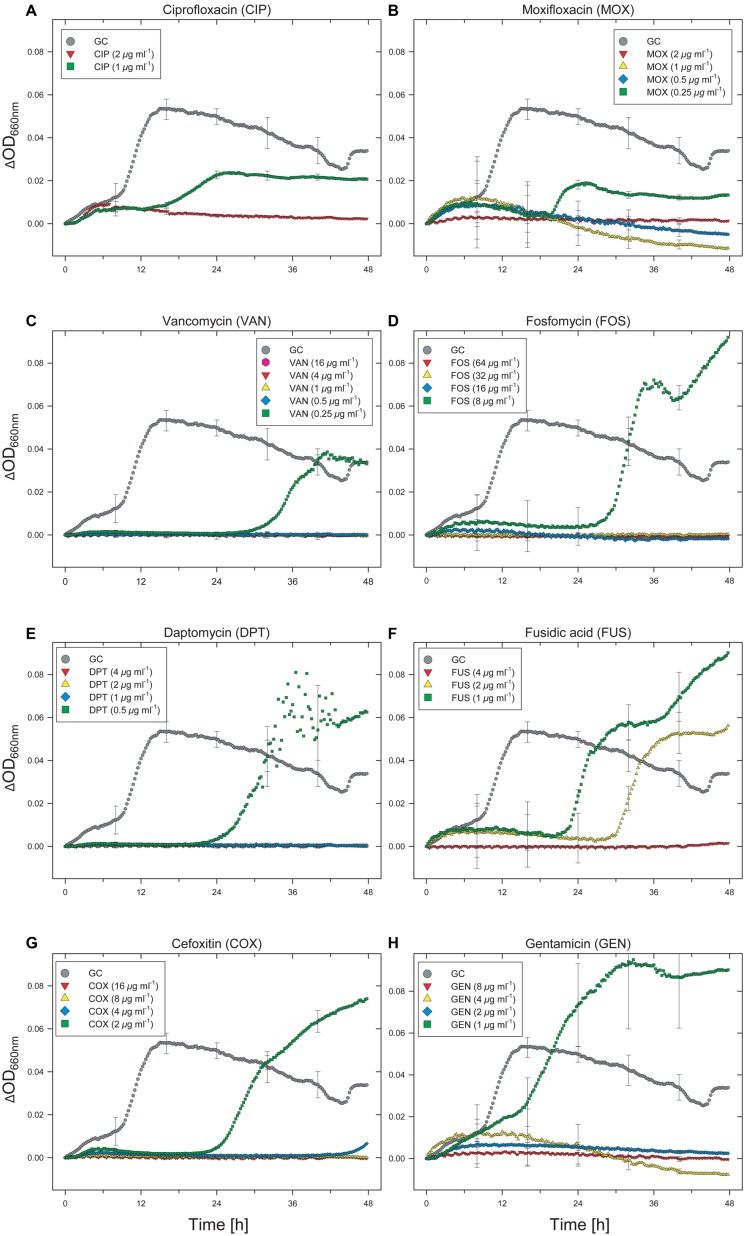
Effect of selected antibiotics on the growth dynamics of Enterococcus faecium strain UKI-MB07. Note the extended lag phase and partial growth promotion at low concentrations for some antibiotics. This hormetic effect was associated with higher maximum specific growth rates and increased OD values. Each data point (time resolution over 48 h: 15 min) represents mean values of triplicate cultivations, normalized with data from identical incubations in the absence of bacterial cells (sterile controls). Hence, each curve represents 576 single data points and kinetics from about 21,900 single data points are shown in this figure. For visual clarity, standard deviations (error bars) are only presented for selected time points.